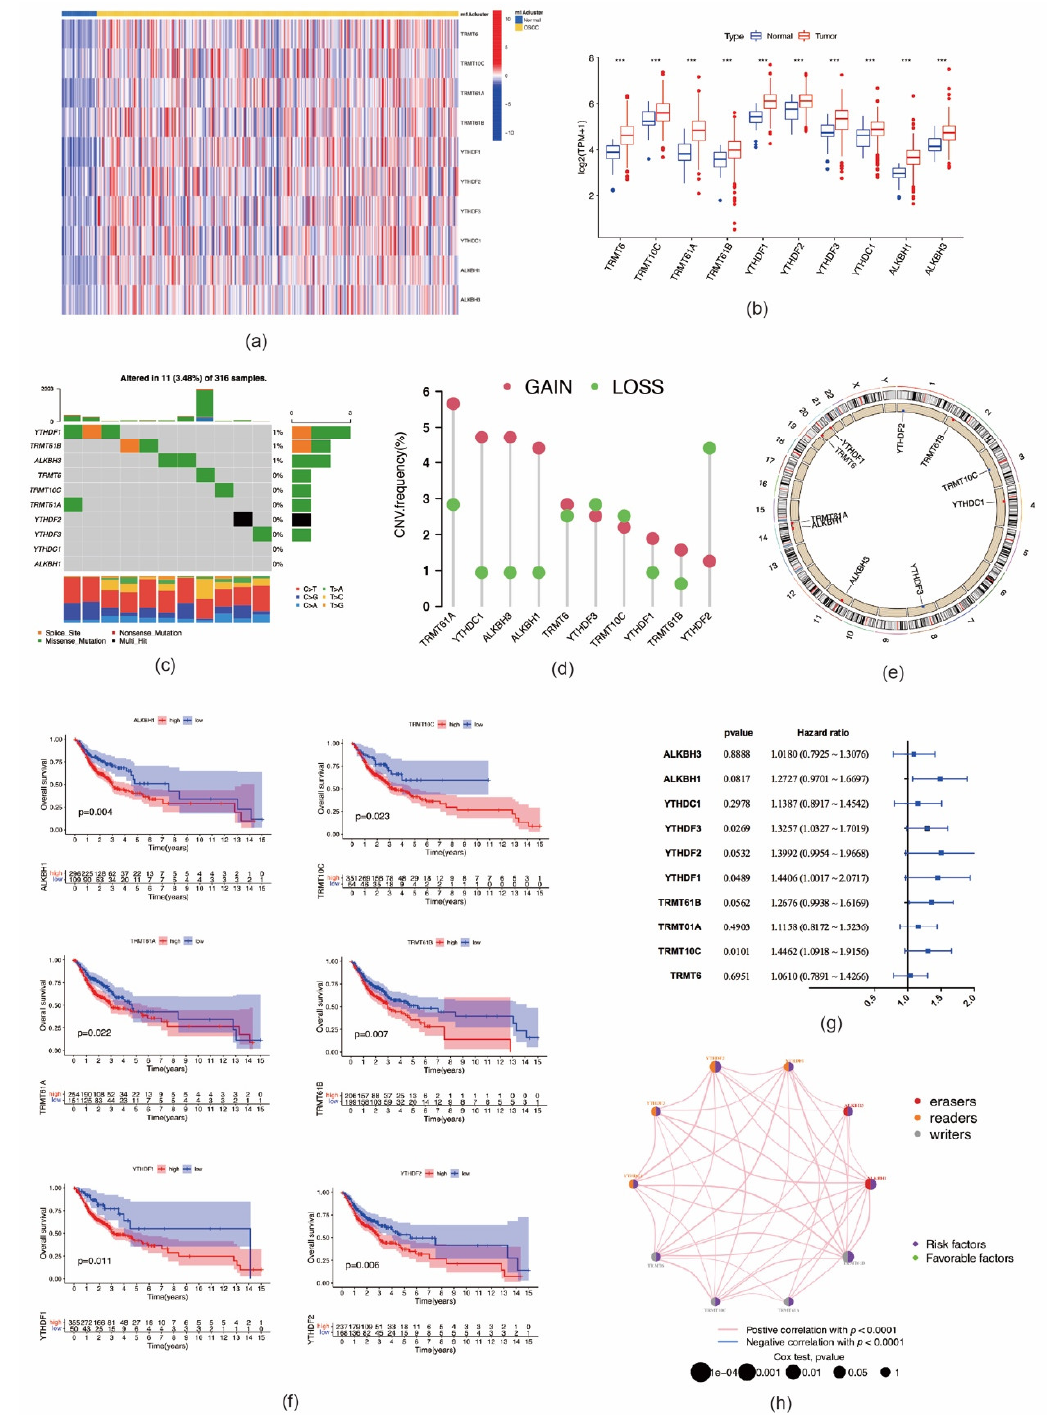
Figure 2. Genetic variation and prognostic relevance of m1A regulators in oral squamous cell carcinoma. ( a ) The expression levels of 10 m1A methylation modification regulators in each clinical sample. ( b ) The expression of 10 m1A methylation regulators between tumor tissues and normal controls (*** p < 0.001). ( c ) 11 of 316 samples (3.48%) from TCGA–HNSCC cohort show genetic alterations of 10 m1A regulators. ( d ) The CNV mutation frequency of m1A regulators in TCGA–HNSCC cohort. ( e ) The location of CNV alteration of m1A regulators on chromosomes. ( f ) Survival analysis of m1A regulators in patients with oral squamous cell carcinoma. ( g ) The prognostic analyses for 10 m1A regulators using univariate Cox regression model. ( h ) The interaction between m1A regulators in oral squamous cell carcinoma. The left part of the circle represents the category of each regulator. Erasers, red; readers, orange; writers, gray. The right part of the circle represents the survival impact of each regulator. Favorable factors of prognosis, green; risk factors of prognosis,